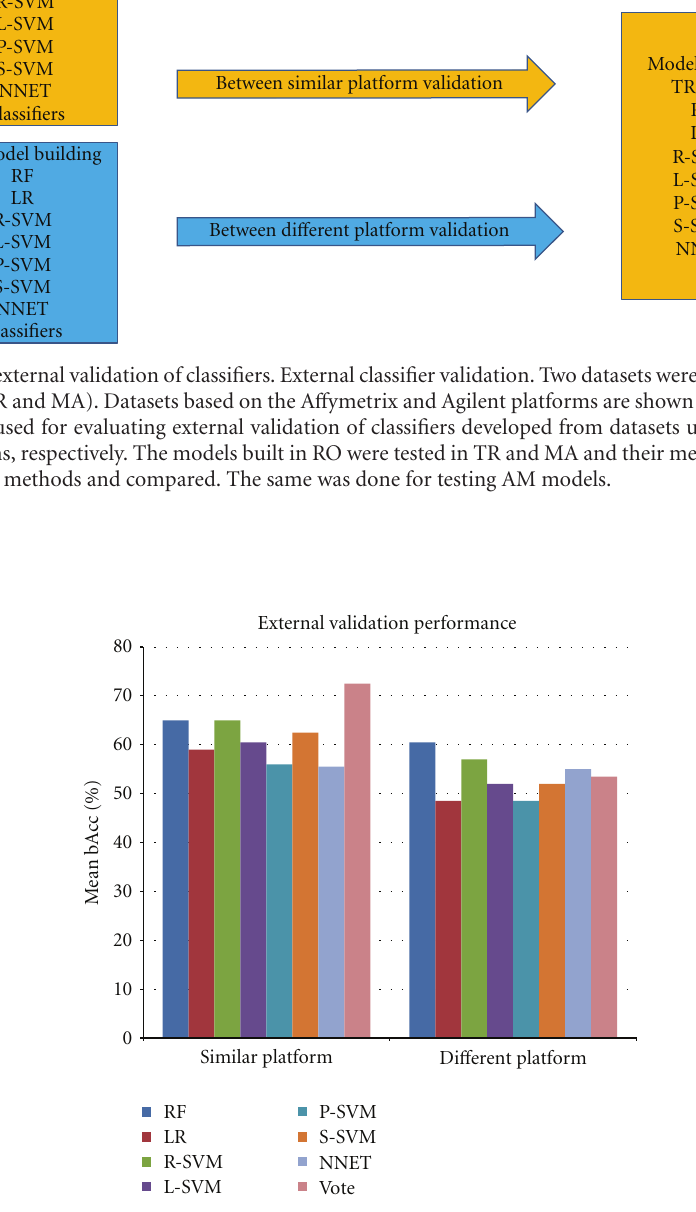
Figure 5: External validation performance. External classifier performance. The histogram shows the mean testing performance when classifiers are validated in test sets based on similar platforms or di ff erent platforms as from which they were developed. Each bar represents the mean balanced accuracy by random forest (RF), logistic regression (LR), support vector machines with a radial (R-SVM), linear (L- SVM), polynomial (P-SVM), sigmoid kernel (S-SVM), a neural network with a single hidden layer (NNET), or cross-method voting (VOTE),